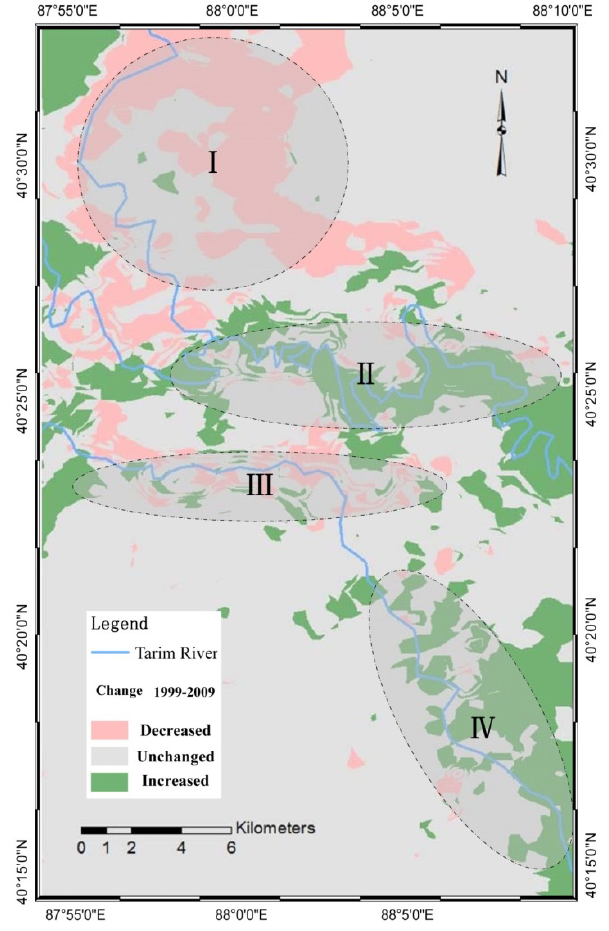
Figure 4. Forest change from 1999 to 2009 and its division into